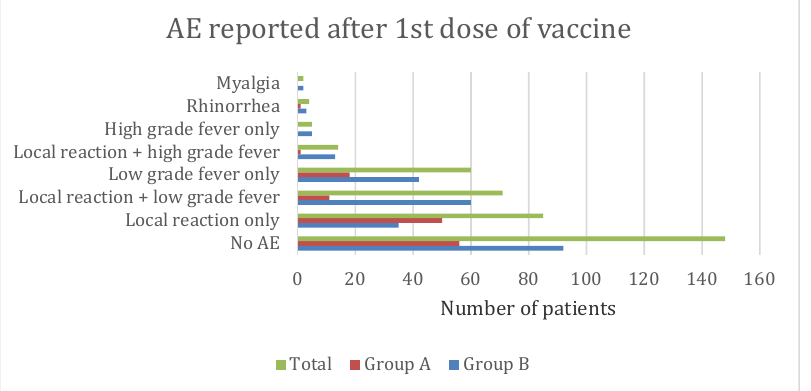
Figure 2. Adverse events (AE) reported following first dose of Pfizer-BioNTech’s m-RNA COVID-19 vaccine in Indian children 5–11 years of age (group A, n = 136) and 12–17 years of age (group B, n = 249). p < 0.001 between the groups on Chi-square test.